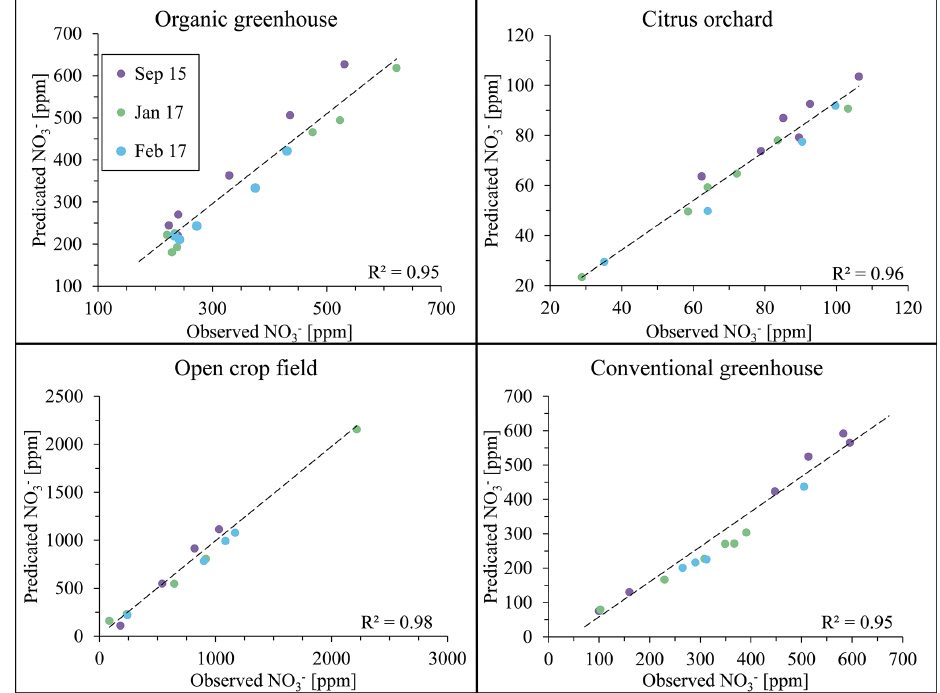
Figure 9. Evaluation of nitrate concentration at the four study sites between the years 2015 and 2017. Note that data points from August 2015 are not plotted as they were used to form the calibration equation for the analyses of the remaining sampling campaigns.